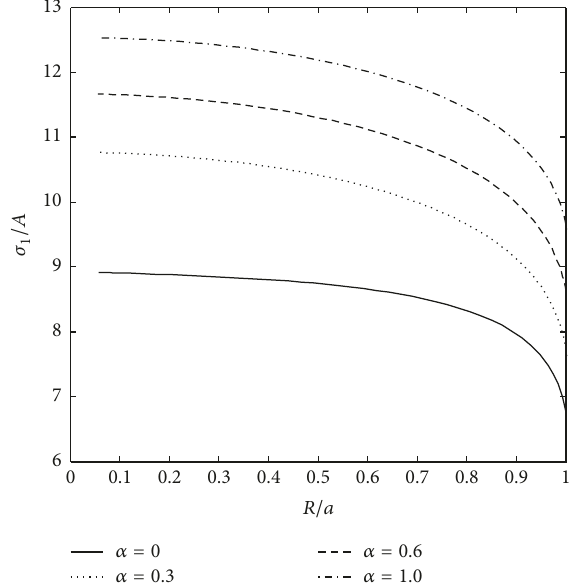
Figure 10: The radical stress distribution on membrane ( 𝑞/𝐴 = 10 ; 𝑛 = 2